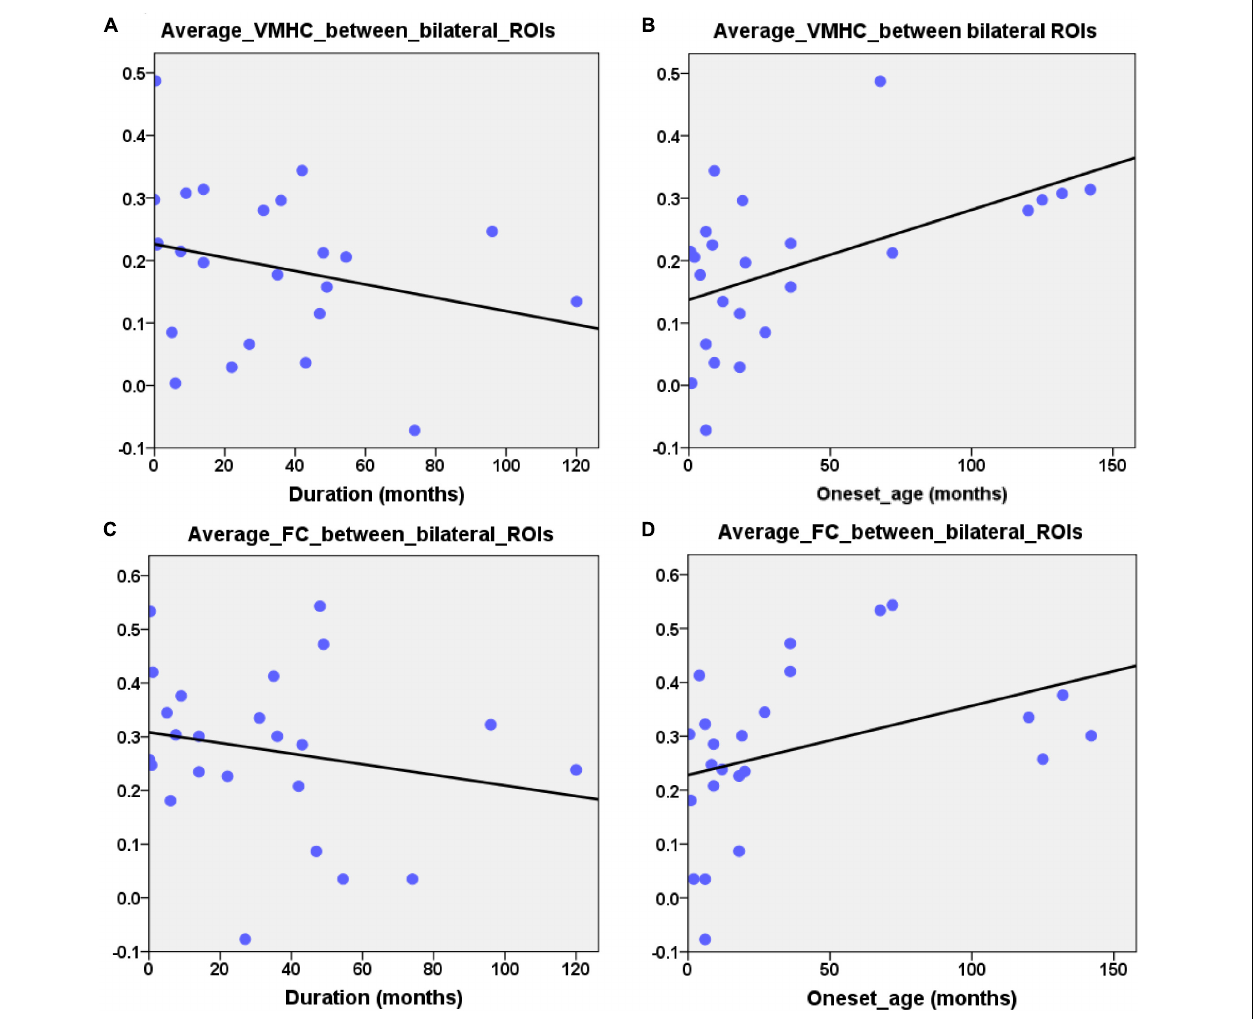
FIGURE 4 | Partial correlation between the neuroimage indexes and the clinical characteristic. (A) Significantly negative correlation between epilepsy duration and the average VMHC values of ROIs (bilateral HF and LTC, r = –0.445, p = 0.038). (B) Significantly positive correlation between the first seizure onset age and the average VMHC values of ROIs (bilateral HF and LTC, r = 0.445, p = 0.038). (C,D) Scatterplot showing correlation between the average FC of bilateral ROIs (HF and LTC) and clinical characteristic (epilepsy duration: r = –0.281, p = 0.205, the onset age of first seizure: r = 0.281, p = 0.205). Age and gender were controlled during the above correlation